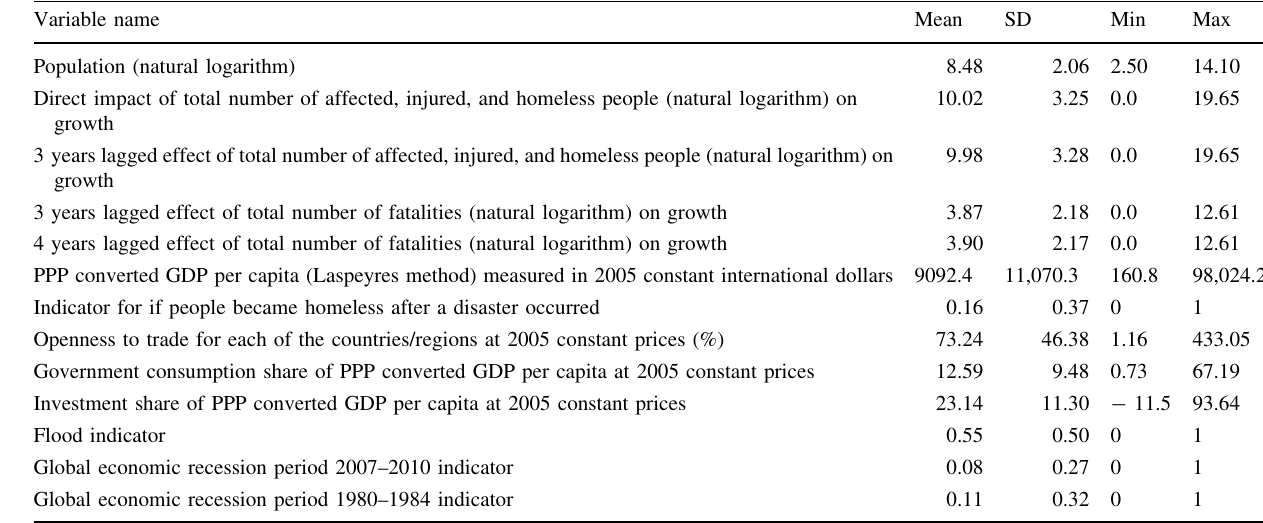
Table 1 Descriptive statistics of statistically significant explanatory variables used in the model Variable